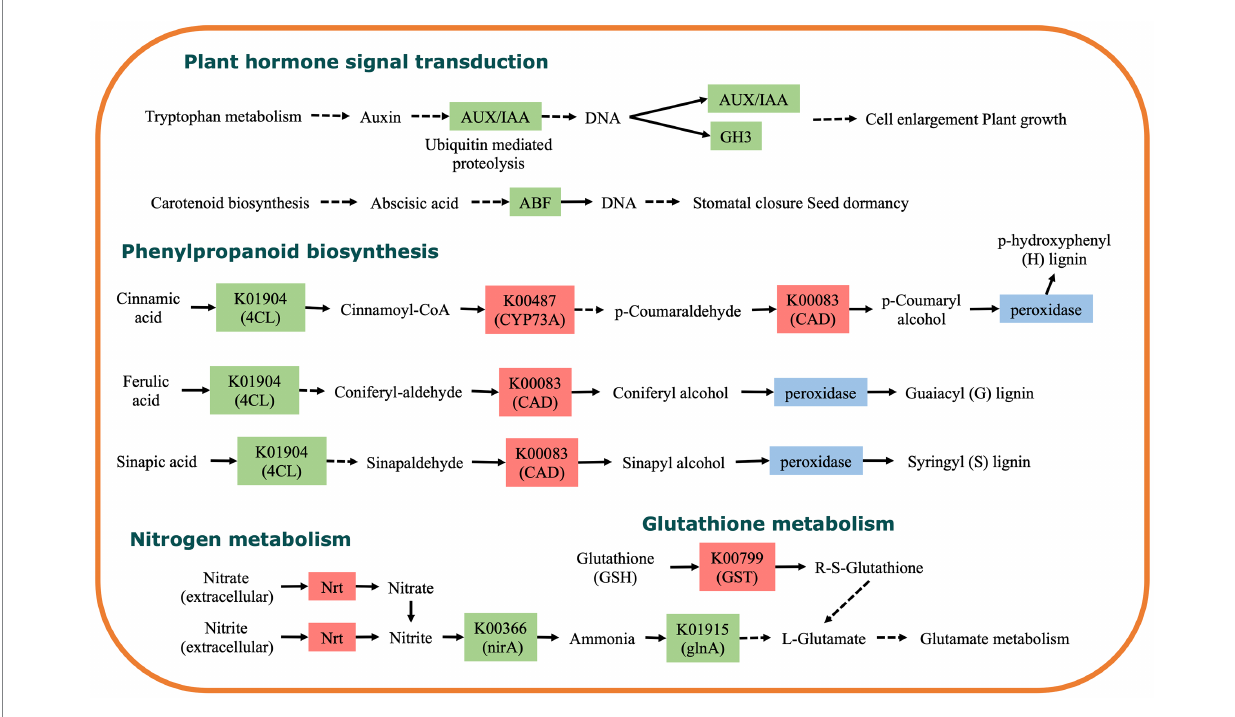
FIGURE 7 KEGG pathway enriched by differentially expressed genes between Cd and Cd + DSE treatments. Colors indicate significant differential expression, red represents up-regulation, green represents down-regulation, and blue represents both up-regulation and